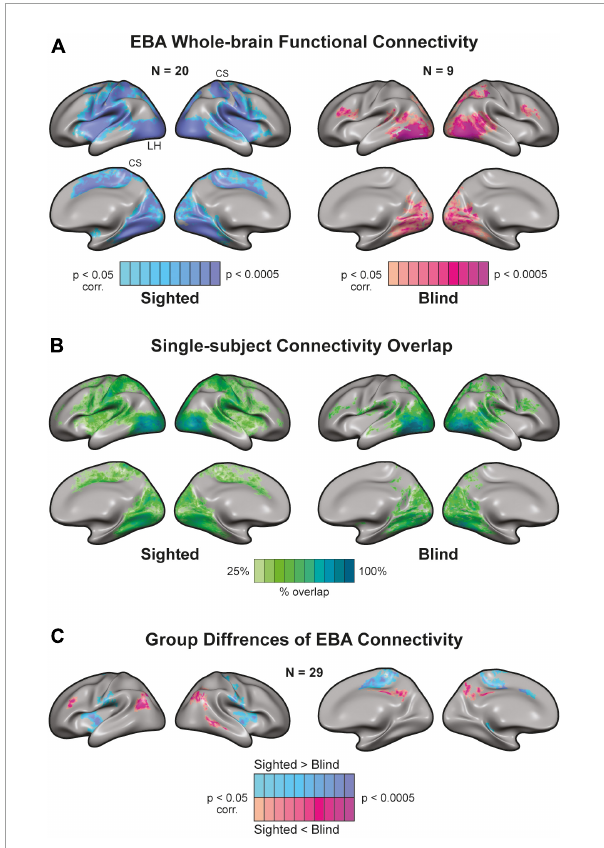
FIGURE3 Whole-brain connectivity of Extrastriate Body Area (EBA) seed in blind and sighted individuals [random effects General Linear Model (GLM)]. (A) There is a high functional connection between the EBA [independent localizer from Human Connectome Project (HCP) atlas] and visual regions in sighted and blind individuals. However, EBA connectivity to sensorimotor areas exhibits a strikingly different picture. EBA has widespread connectivity to sensorimotor cortices in the sighted. Yet, there is a disconnection between EBA and sensorimotor regions in the congenitally blind. CS, central sulcus. (B) Single-subject connectivity overlap in sighted and blind groups. We created the probabilistic maps from single-subject EBA connectivity results. Connectivity to visual areas was consistent across blind and sighted participants. In addition, there was a connectivity overlap in the sighted around S1, M1, and associative sensorimotor cortices. (C) Group differences of EBA connectivity. The sighted had higher connectivity around sensorimotor